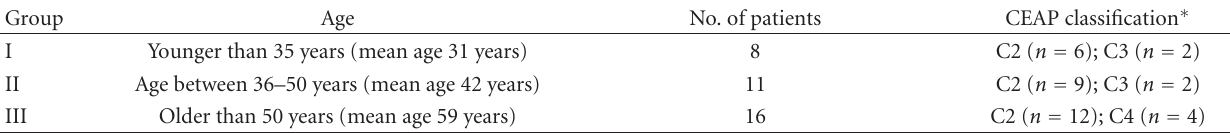
CEAP classification: classification system of varicose veins accounting clinical, etiological, anatomical, and pathophysiological aspects.